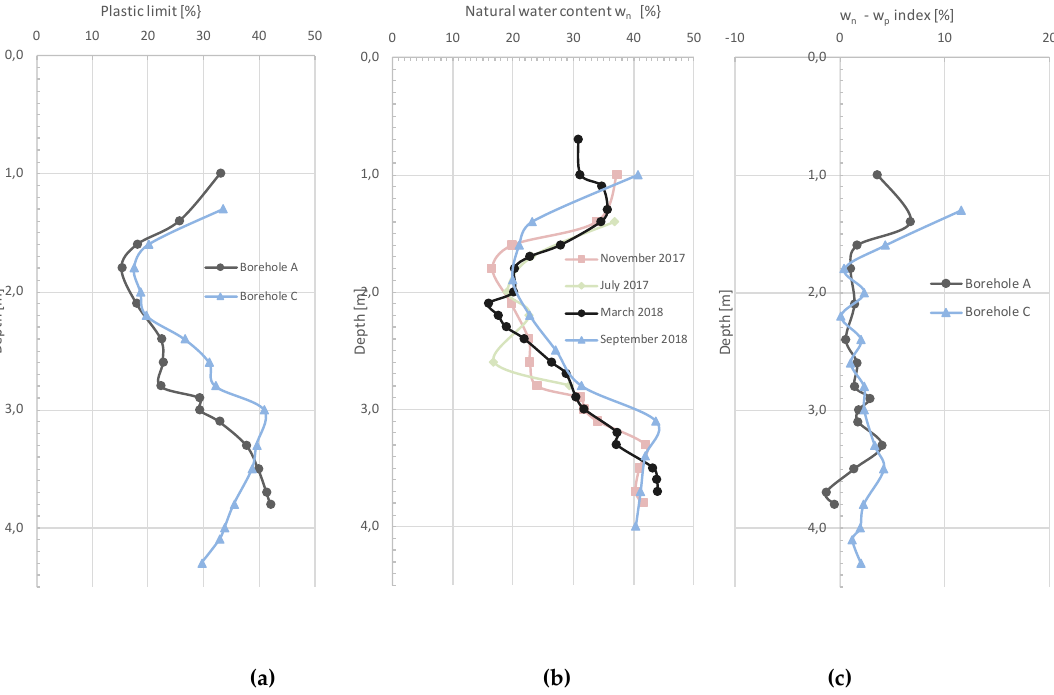
Figure 6. The monitored boreholes: (a) plastic limit in monitored boreholes (A, C), (b) fluctuations of the natural water content in the monitored period in borehole A, (c) w n -w p index in monitored boreholes.